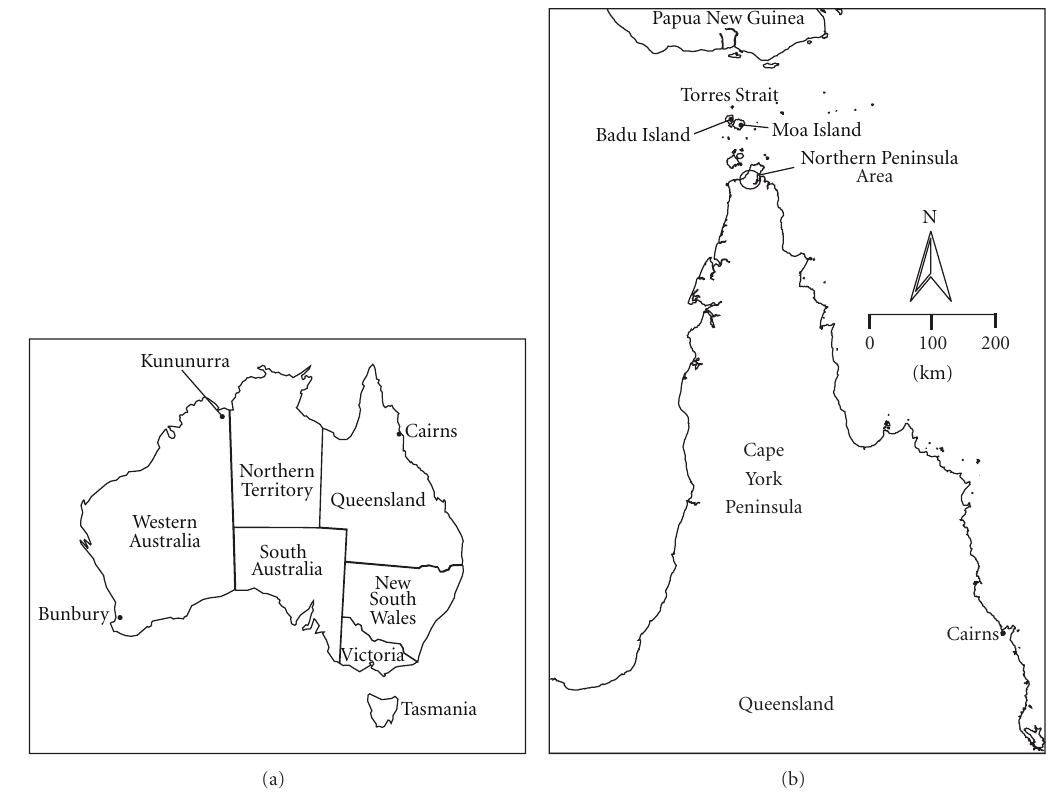
Figure 1: Map of (a) Australia and (b) northern Queensland showing locations mentioned in the